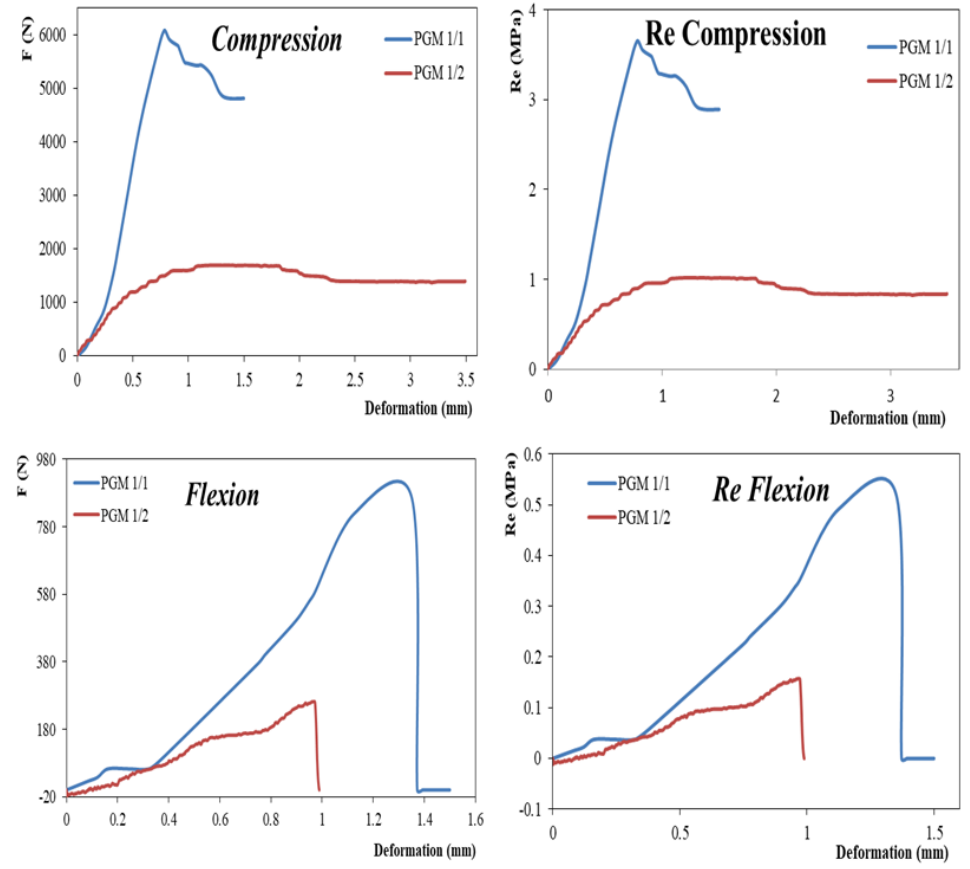
Figure 9. Compressive force, compressive strength, flexion force and flexion strength curves of the